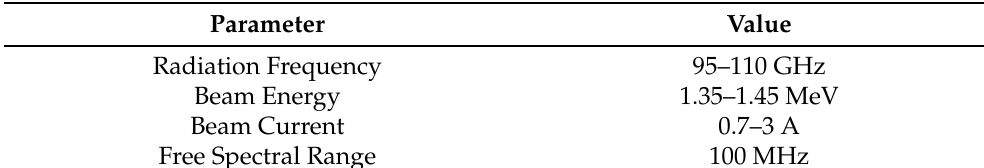
Table 2. Israeli EA-FEL properties.